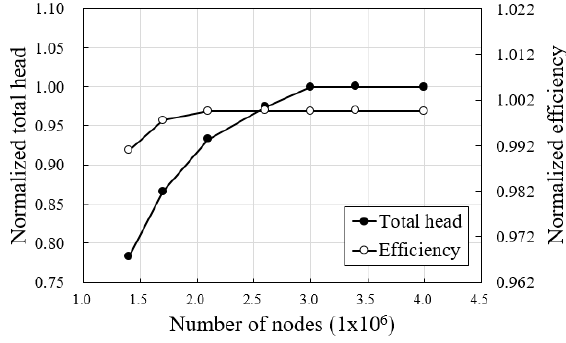
Figure 10. K-fold cross-validation.